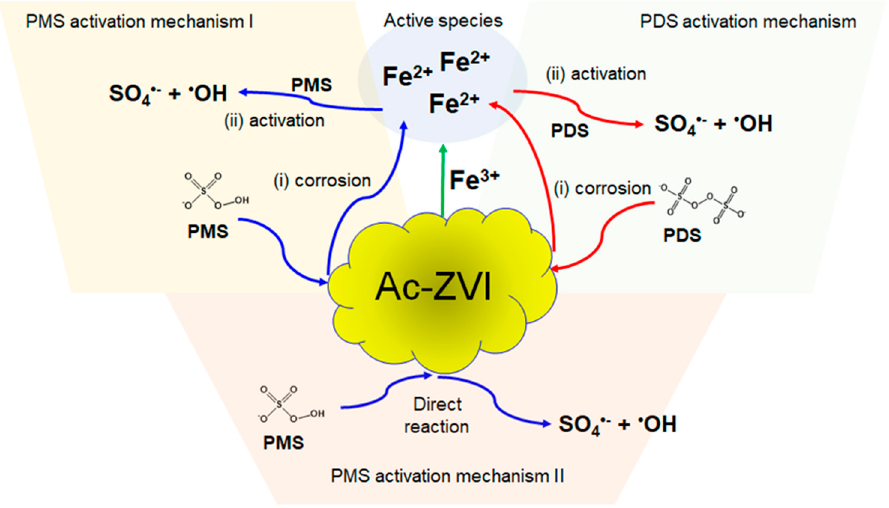
Figure 2. Schematic illustration of the PMS and PDS activation by ZVI.